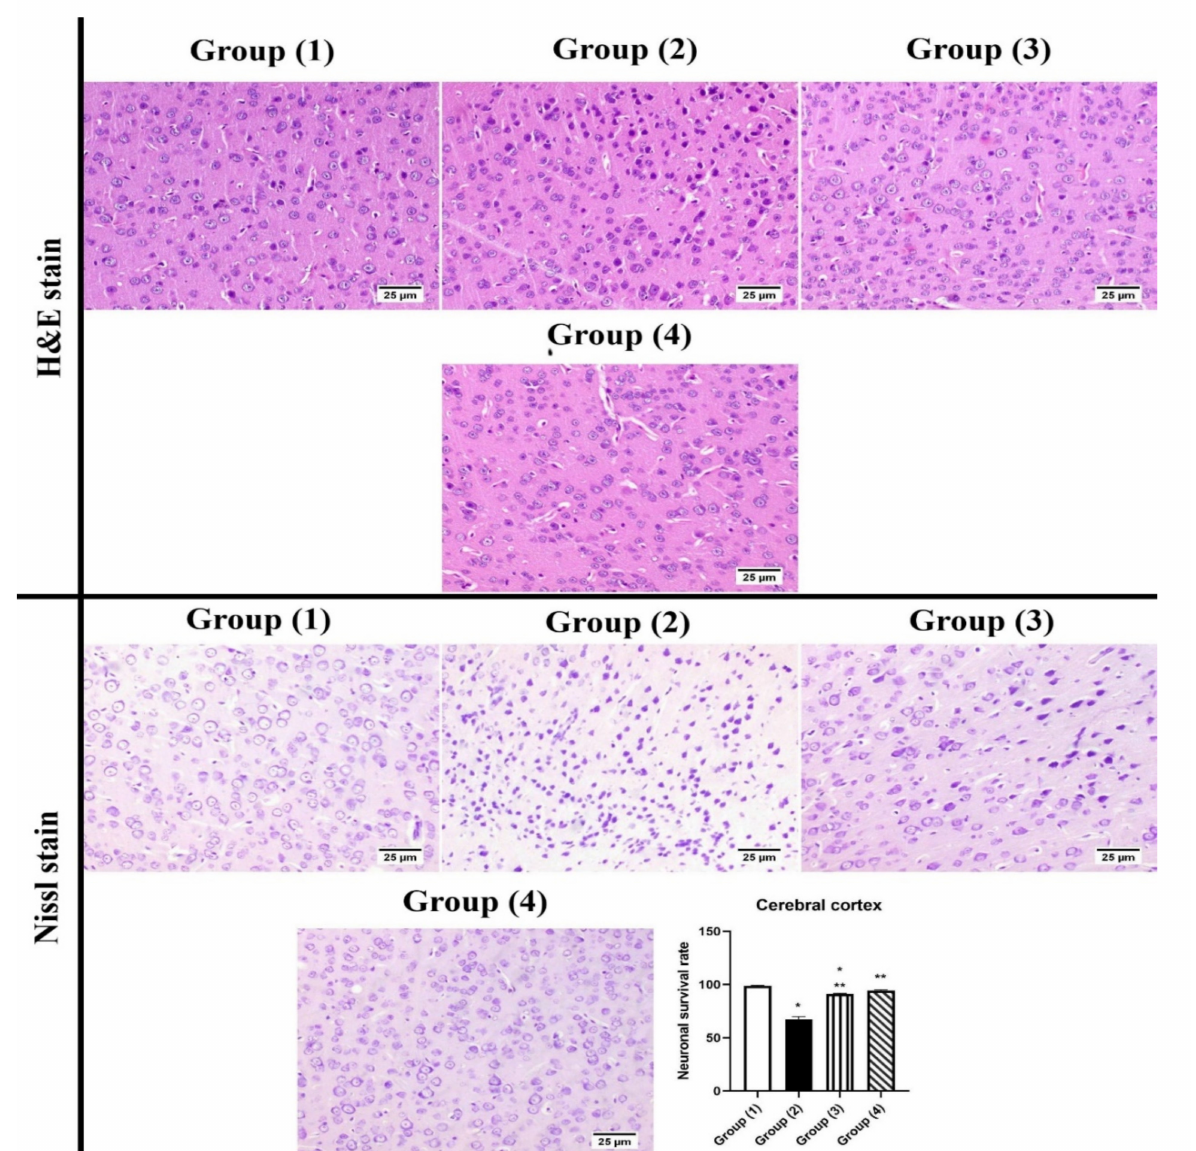
Figure 5. Photomicrograph of brain, cerebral cortex (H&E and Cresyl violet stains). Normal hip- pocampus in group (1), group (2) showed numerous shrunken neurons. Group (3) showed few degenerated neurons. Group (4) showed apparently normal cerebral cortex. The chart represents neuronal survival rate, statistical analyses were performed using ANOVA (one-way analysis of variance) followed by Tukey post hoc test. Each value was expressed as mean ± SD. *: Statistically significant different from the normal group at p < 0.05, **: Statistically significant different from the positive control group (STZ, 3 mg/kg) at p <